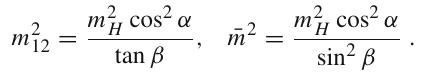
Fig. 5 Allowed areas in two selected Higgs masses of the 2HDM parameter space, delimited by the theoretical constraints from unitar- ity (green areas), stability (red areas), and both together (dotted areas), obtained from Eqs. (18) to (28). The alignment limit is assumed and